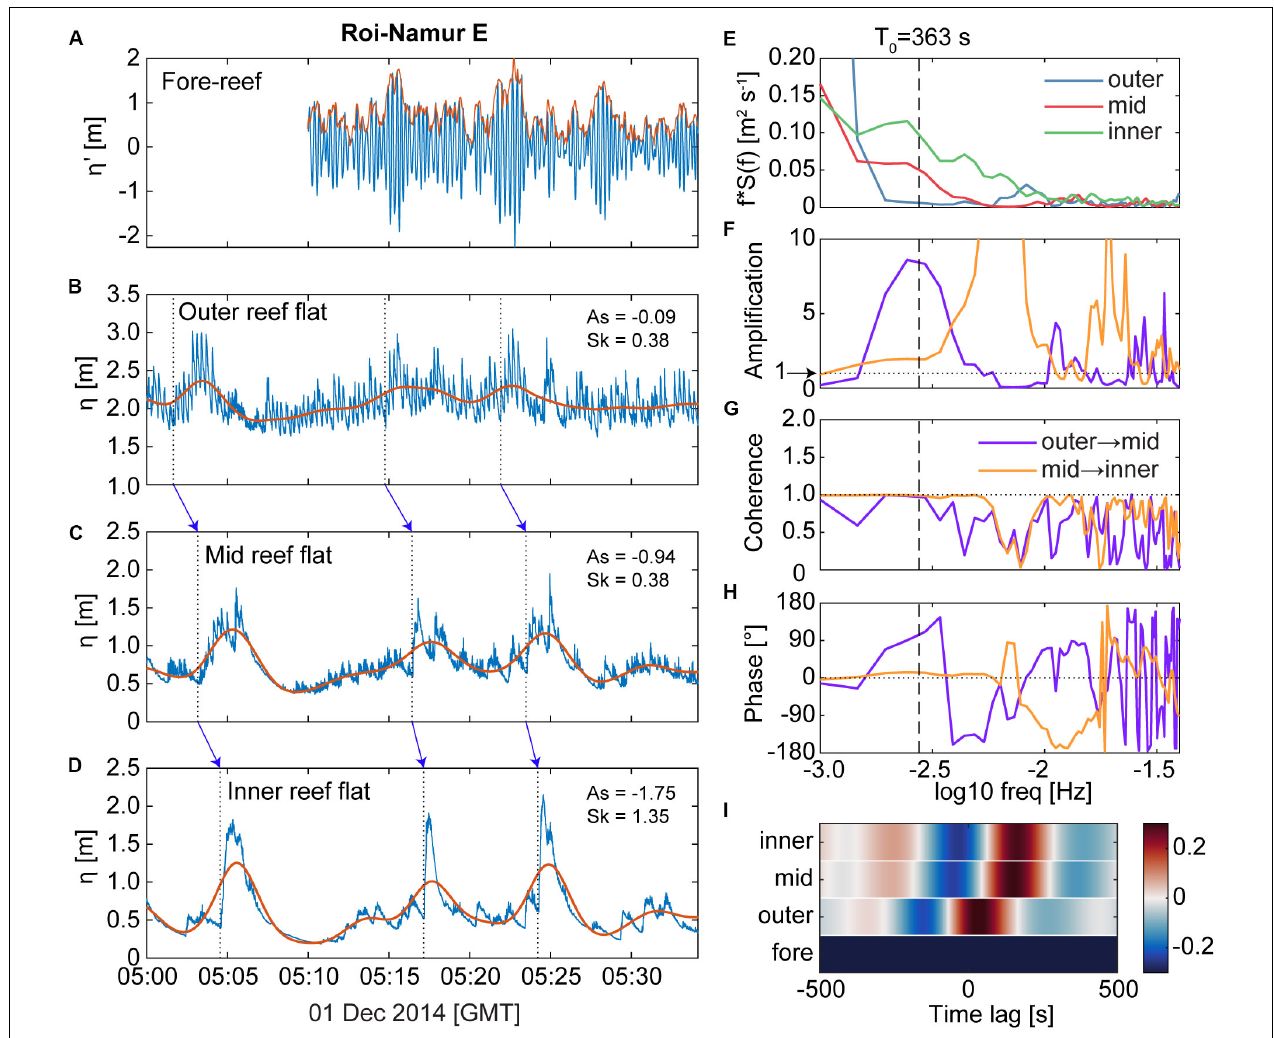
FIGURE 8 | Another example of how large, very-low frequency (“VLF”) motions can facilitate the growth of large infragravity (“IG”) bores on reef flats, using observations from Roi-Namur E during a large offshore wave event on 1 December 2015. (A) Fore-reef water levels relative to the mean (blue) with the sea-swell (“SS”) wave envelope (red) overlaid. Due to data fouling of the Roi-Namur E fore-reef pressure sensor, these fore-reef water levels are taken from the AWAC pressure sensor, which did not begin its burst sampling till 10 min past the hour (see section Materials and Methods). Reef-flat water levels (blue) and the low-pass filtered VLF water levels (red line) shown for the (B) outer, (C) mid, and (D) inner reef flat. Dashed lines and corresponding blue arrows highlight a few selected leading edges of wave packets that transforms into a steep, asymmetrical IG bores by the inner reef flat. (E) Variance-preserving energy density spectra from the reef flat water levels shown in (B–D) over the IG and VLF bands; the fundamental resonant frequency ( T 0 ) is indicated by the dashed line. (F) Amplification in energy across the reef flat. (G) Coherence between the spectra. (H) The phase between the spectra. (I) Cross-correlation between the outer reef-flat water level and the mid and inner reef flat water levels for different time lags; the available fore-reef water level did not correlate well with the reef flat water levels. No photo was available for this site. Similar to the example shown in Figure 7 , there is strong evidence for VLF resonance or standing wave behavior: the reef flat water levels display amplification and strong coherence near T 0 , and a near-zero lag and strong cross-correlation between the mid and inner reef flat. The resulting IG bores at the inner reef flat had heights > 1 m.